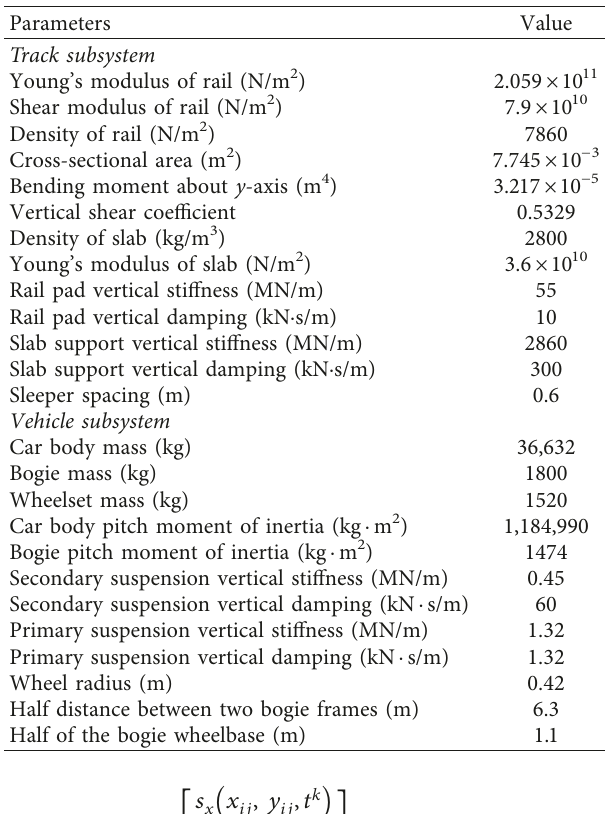
Table 1: Parameter values of the track and vehicle